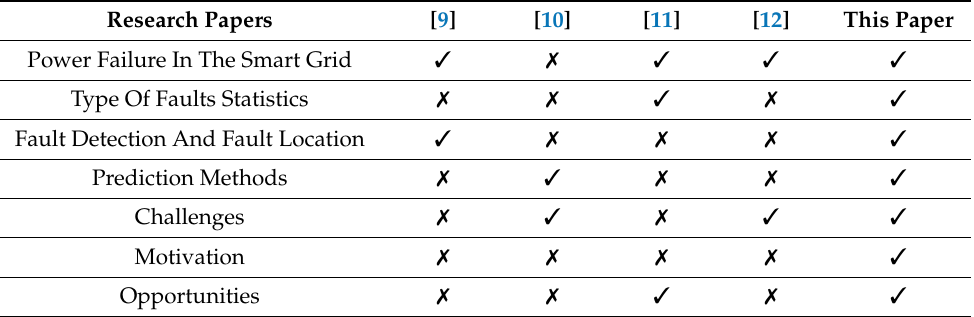
Table 1. Comparison of different research review